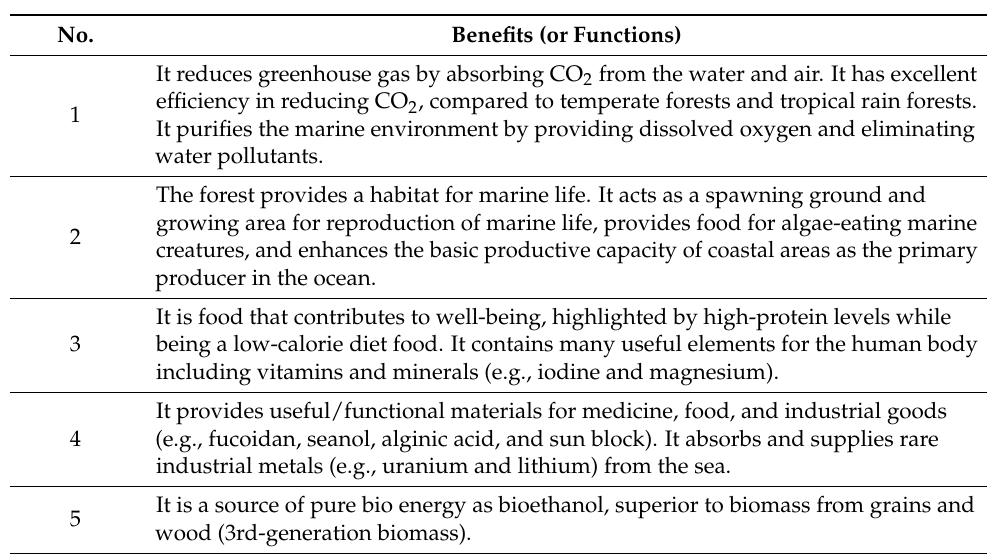
Table 3. Major benefits (or functions) of macroalgal forests